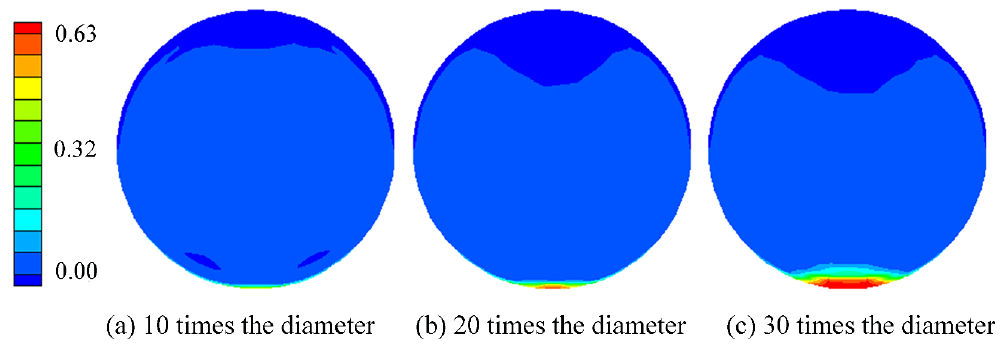
Figure 6. Sand concentration contours at different cross-sections of the multiphase flow pipeline.